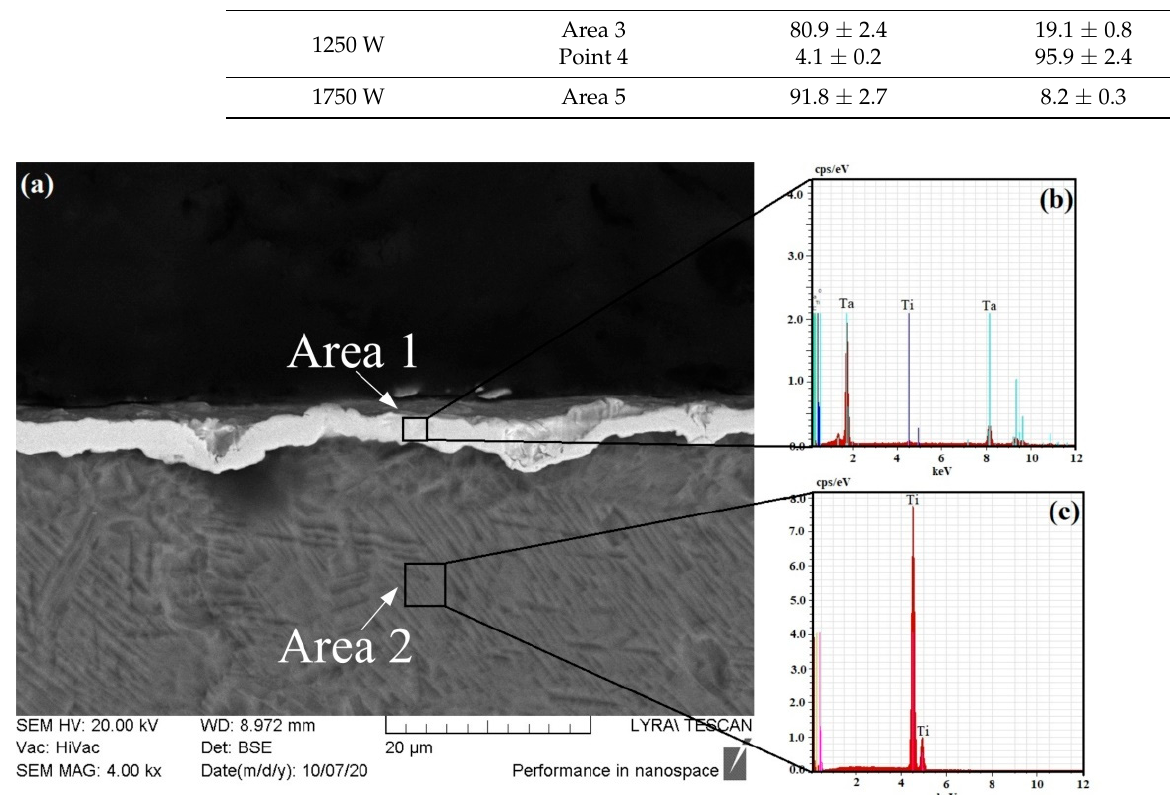
Table 1. Chemical composition of each measured area/point marked on the cross-sectional SEM images (Figures 2–4). Specimen Area/Point Ti, wt.% Ta, wt.% Area1 750 W